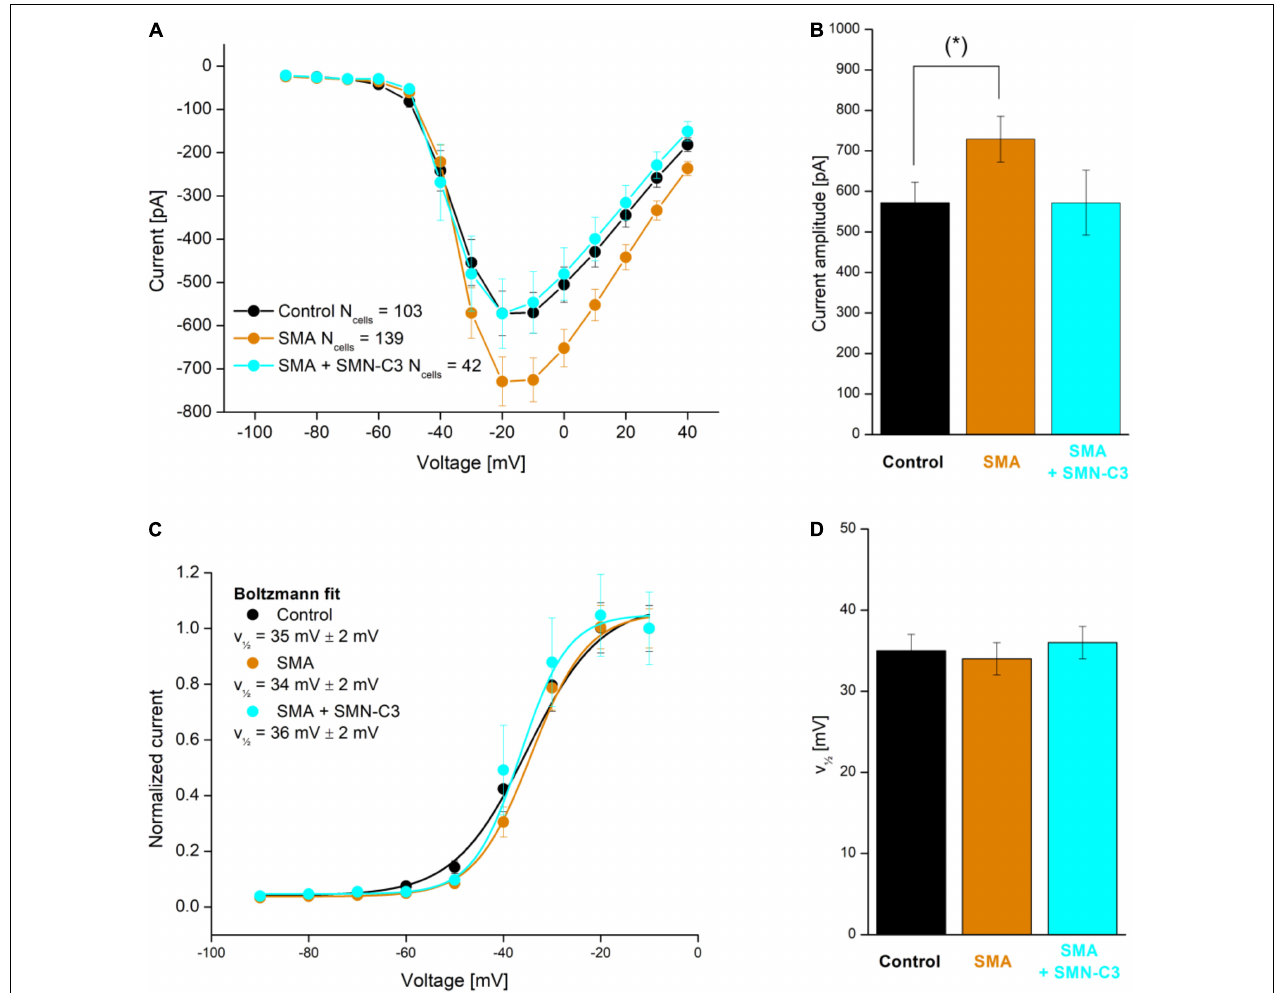
FIGURE 8 | APC evaluation of compound effects on Na v channel properties in SMA hiPSC-neurons. Parallel recordings of control neurons (black), SMA neurons (orange), and SMA neurons treated with SMN-C3 during culturing (blue). (A) Average Na v current versus step voltage. (B) Quantification of the current amplitude